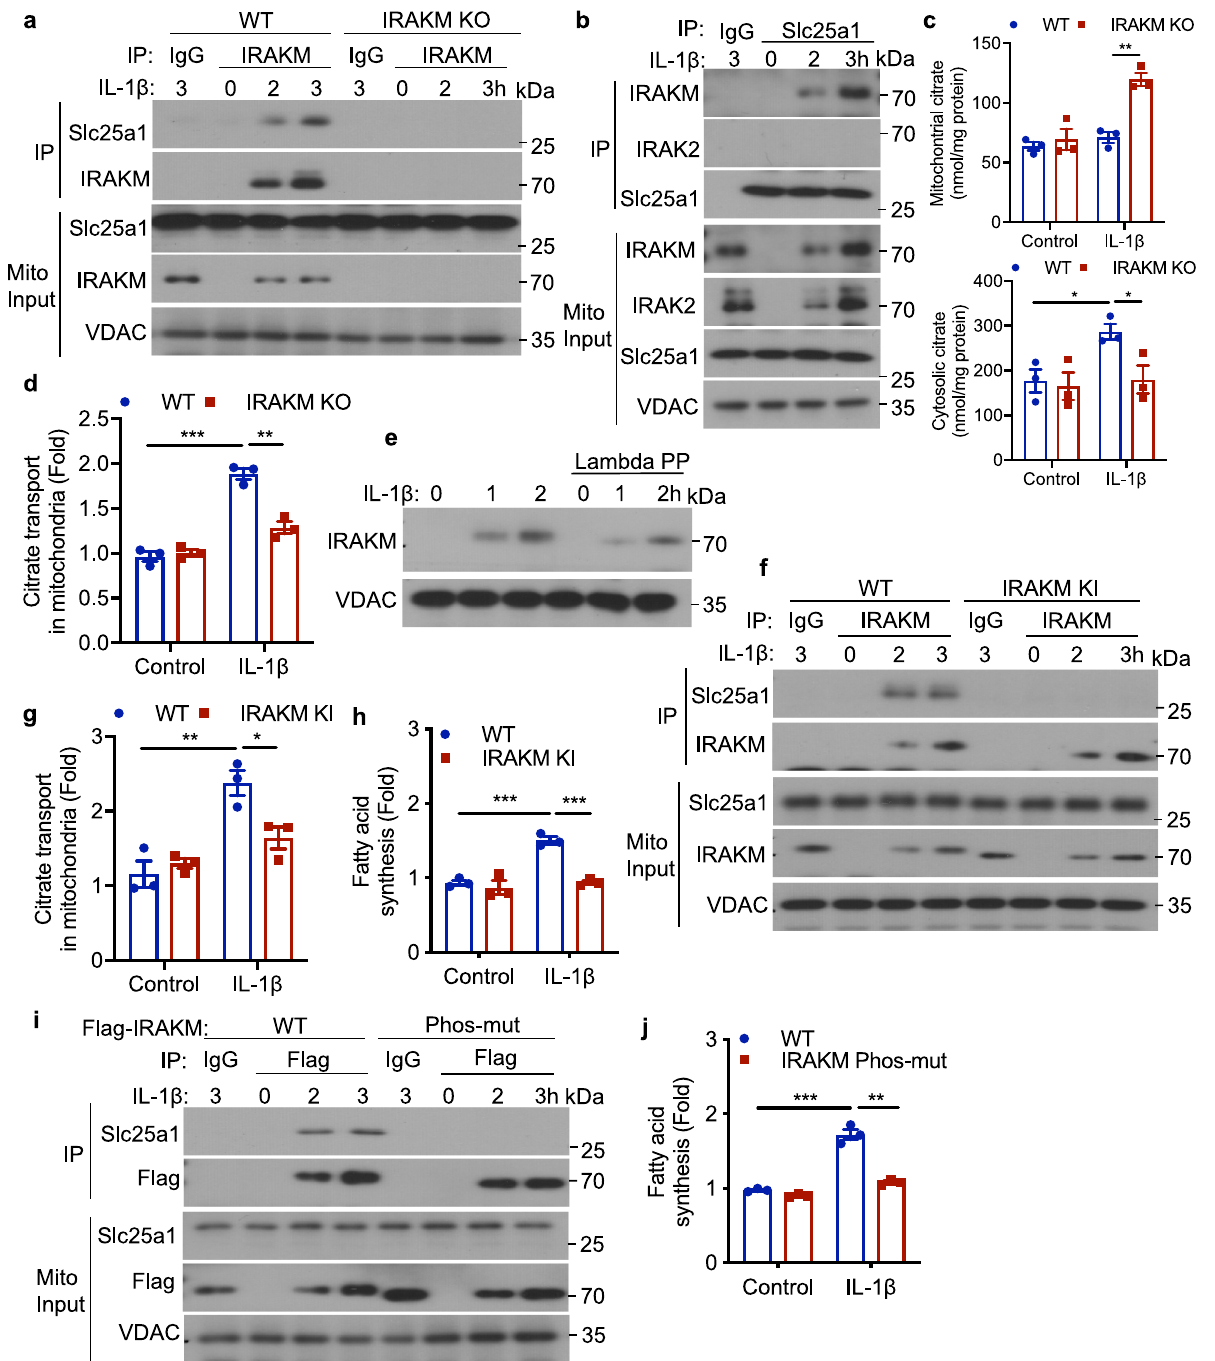
(Supplementary Fig. 7g). WT and IRAKM KI mice were also fed with the high carbohydrate/zero-fat diet (ZFD) to maximize de novo lipogenesis. Compared to control mice, IRAKM KI mice gained less body weight and much less fat mass without impacting lean mass after ZFD feeding (Fig. 7g, h, Supplementary Fig. 7h). Consistently, IRAKM KI BAT had much reduced lipid accumulation (Fig. 7i). Thermogenic genes expression was increased (including Pgc1a , Prdm16 , Cidea , and Ucp1 ) in iWAT (Supplementary Fig. 7i) and BAT (Fig. 7j, k) of ZFD-fed IRAKM KI mice accompanied with higher body temperature (Supple- mentary Fig. 7j). Consistent with IRAKM AKO mice, HFD-fed IRAKM KI iWAT and BAT had much less